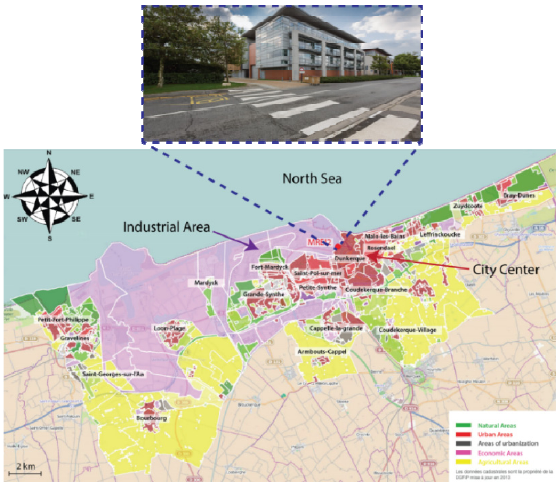
Figure 7. Campaign site. Figure 7. Campaign